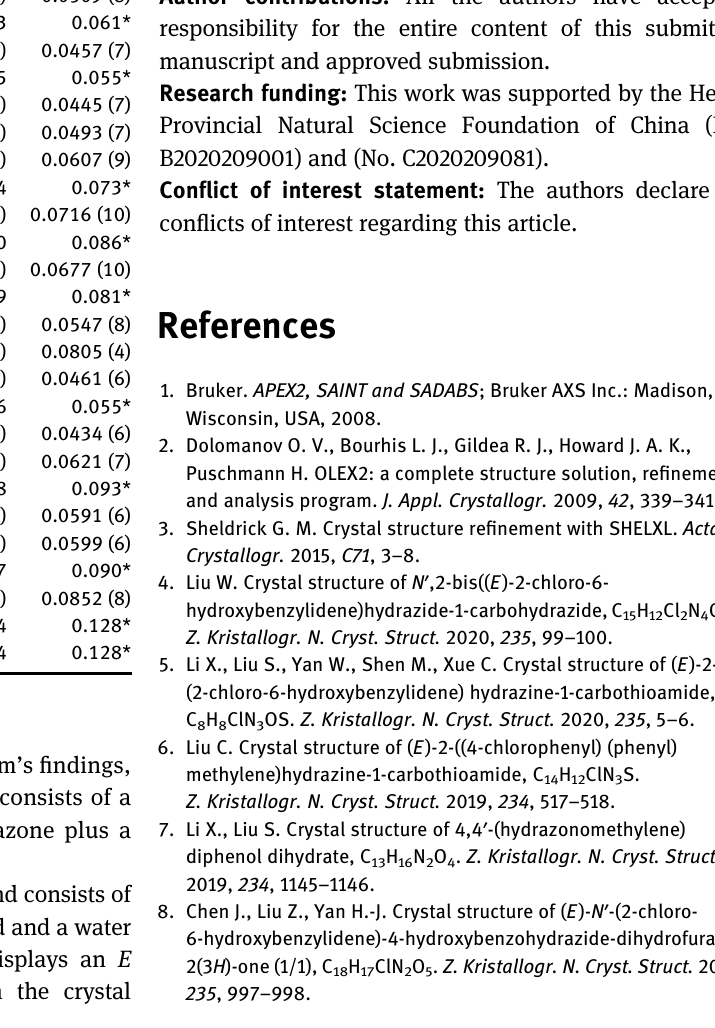
structure, the short distance d (N2 — C8) = 1.270(3) Å exhibits a typical C=N double bond. The C8=N2 – N1 angle of 119.2(2) ° is smaller than the ideal value of 120 ° expected for sp 2 -hybridized N atoms. The dihedral angle formed by the two aromatic rings is 10.147(1) ° . In the crystal structure, the molecules are linked into two-dimensional networks by O — H / O and N — H / O hydrogen bonds. In addition, the intramolecular O — H / N hydrogen bond further consolidates the crystal structure. The bond lengths and angles are in the expected ranges.